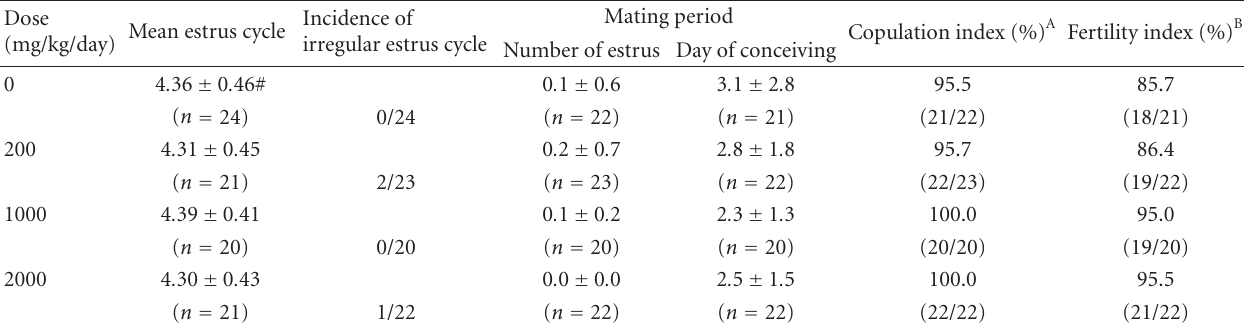
Table 6: E ff ect of SE5-OH administration on the F 1 generation rat dam reproductive performance. Dose Incidence of Mean estrus cycle (mg/kg/day) irregular estrus cycle